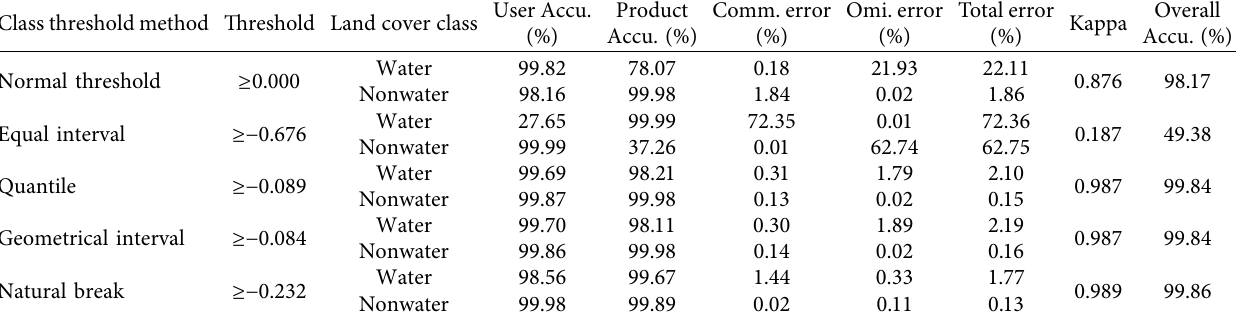
Table 3: Summary of the classification accuracy assessment of the AWEI threshold